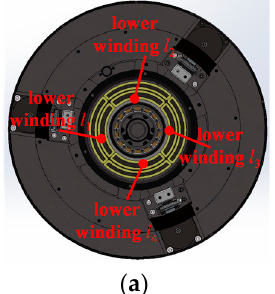
Figure 3. The structure and force models of the 3 ‐ DoF axial AMB. ( a ) The upper end of the 3 ‐ DoF axial AMB; ( b ) the force distributions of the 3 ‐ DoF axial AMB; ( c ) the force distributions of the 3 ‐ axial AMB; ( b ) the force distributions of the 3-DoF axial AMB; ( c ) the force distributions of the 3-DoF DoF axial AMB. axial